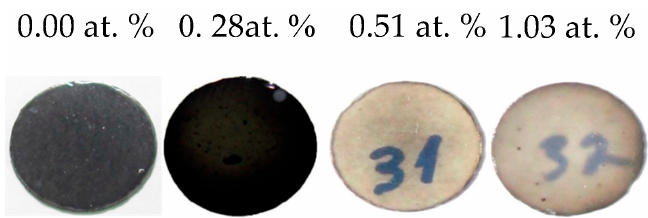
Figure 2. Photograph of Li-MgO·1.06Al 2 O 3 SPS-processed samples. The polished specimens are 10 mm in diameter and ~1.5 mm thick. The effect of lithium on transparency is visible .